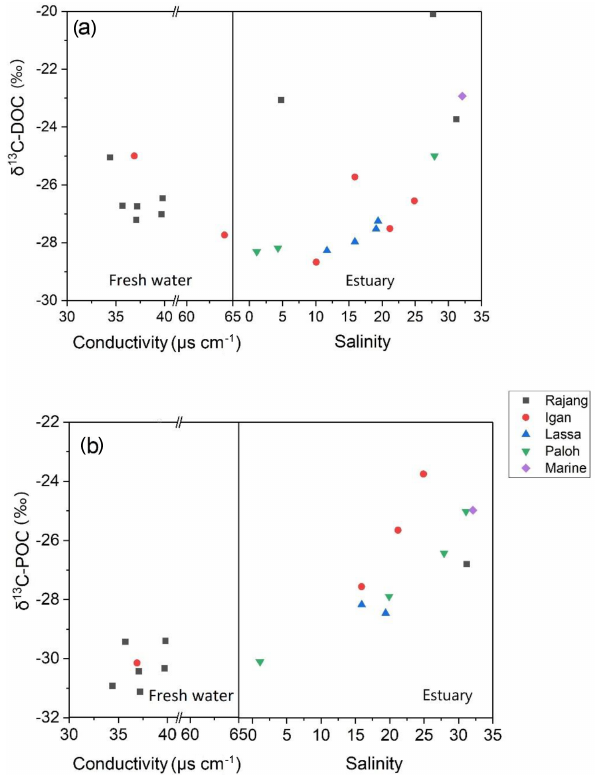
Figure 3. Distribution patterns of (a) DOC- δ 13 C and (b) POC- δ 13 C along with conductivity and salinity in the Rajang. The legend in- dicates the branches that the samples were collected from, and the marine data points correspond to station